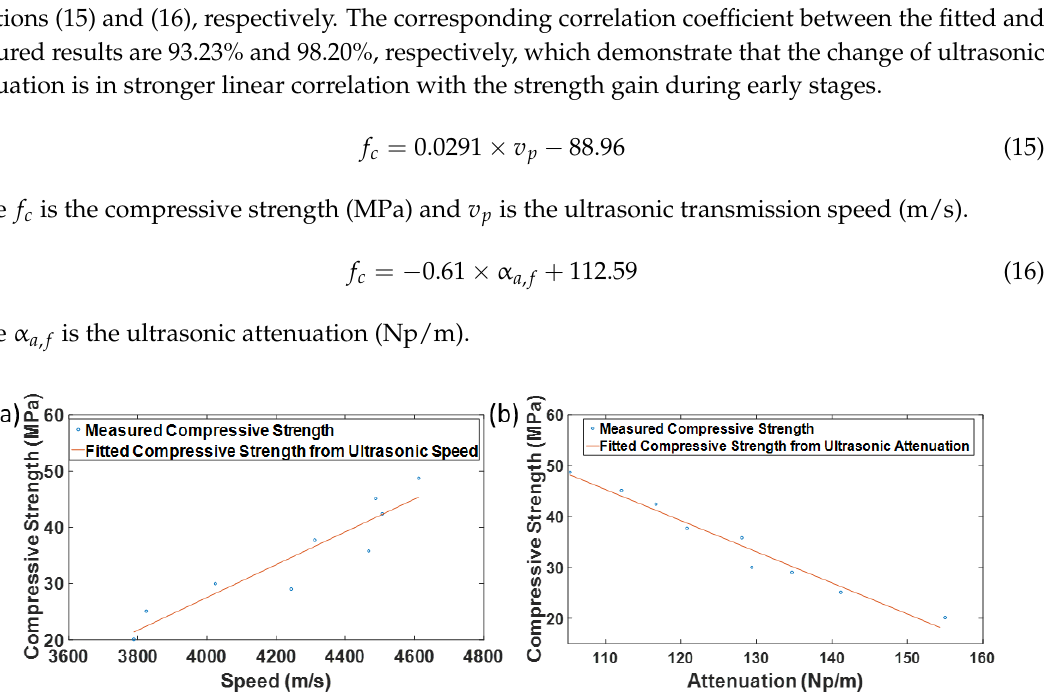
Figure 9. The comparison between the fitted and measured compressive strength. ( a ) The fit between the compressive strength and ultrasonic speed; ( b ) The fit between compressive strength and ultrasonic attenuation.